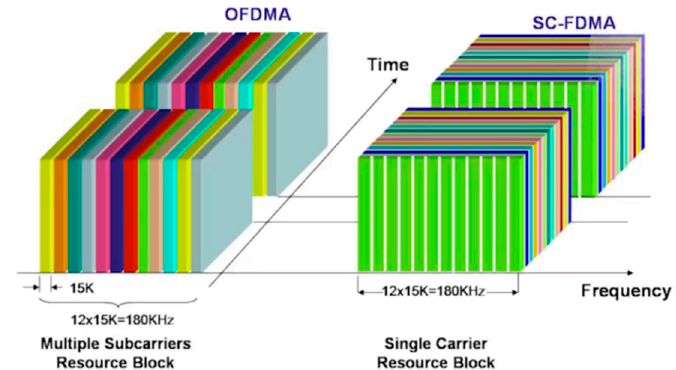
Figure 2. 4G radio access techniques.